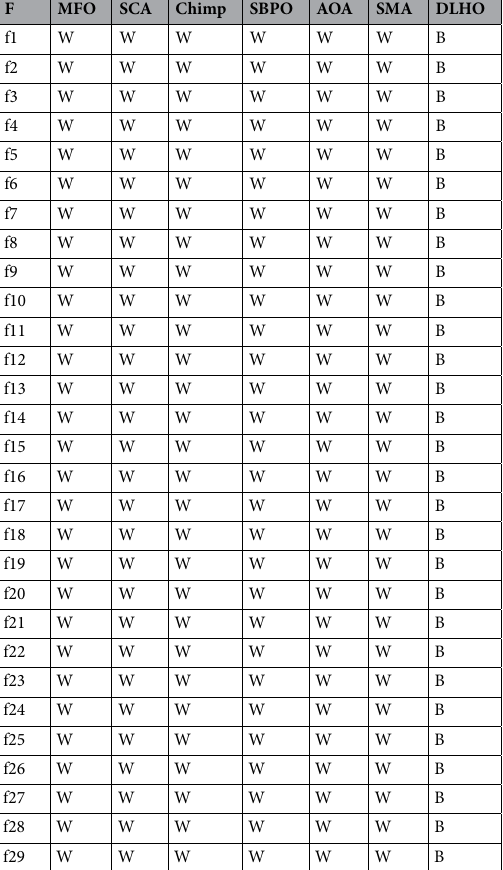
Table 7. Best and worst mean ( µ ) outcomes of optimizers on 29-CEC-2017 functions.